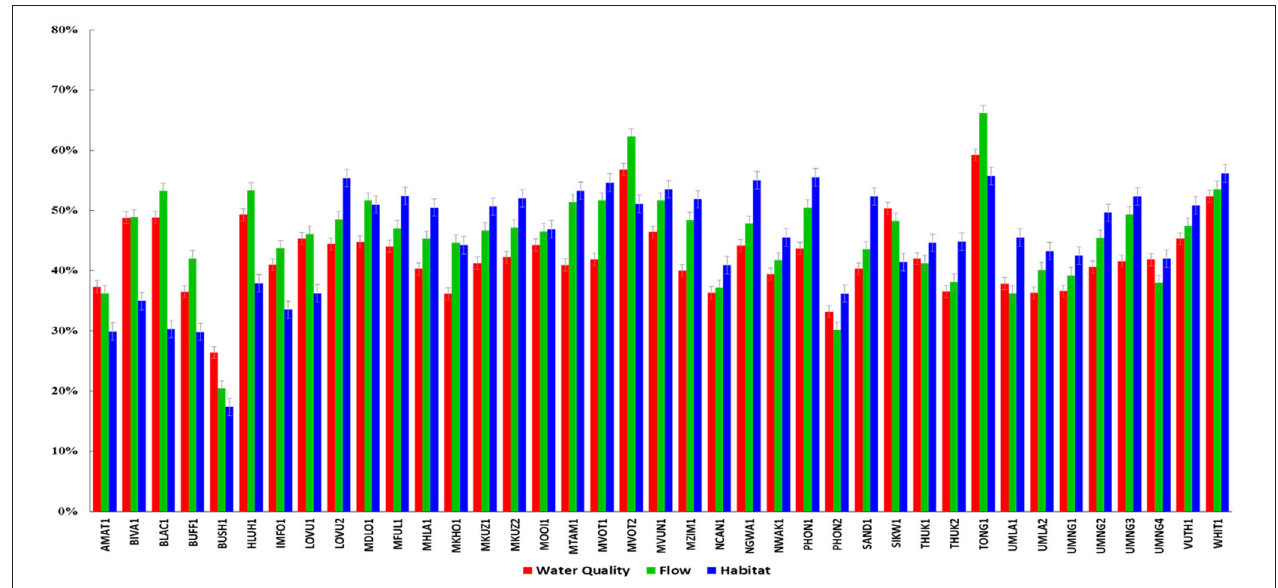
FIGURE 3 | Preliminary analysis of the risk sources for rivers of KwaZulu-Natal, South Africa, from 2015 to